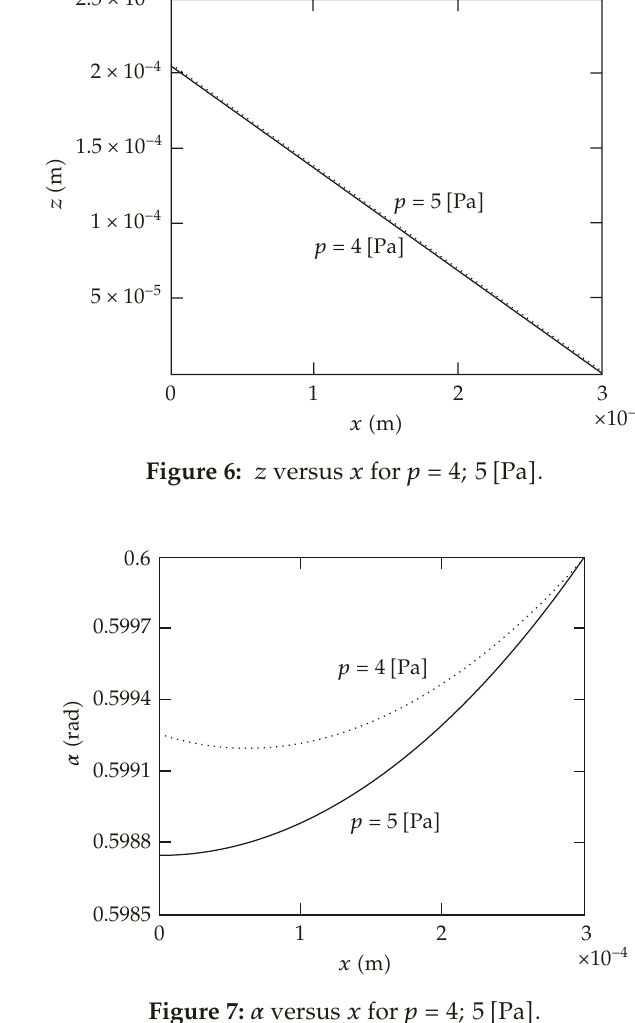
Figure 7: α versus x for p (cid:8) 4; 5 (cid:6) Pa (cid:7)